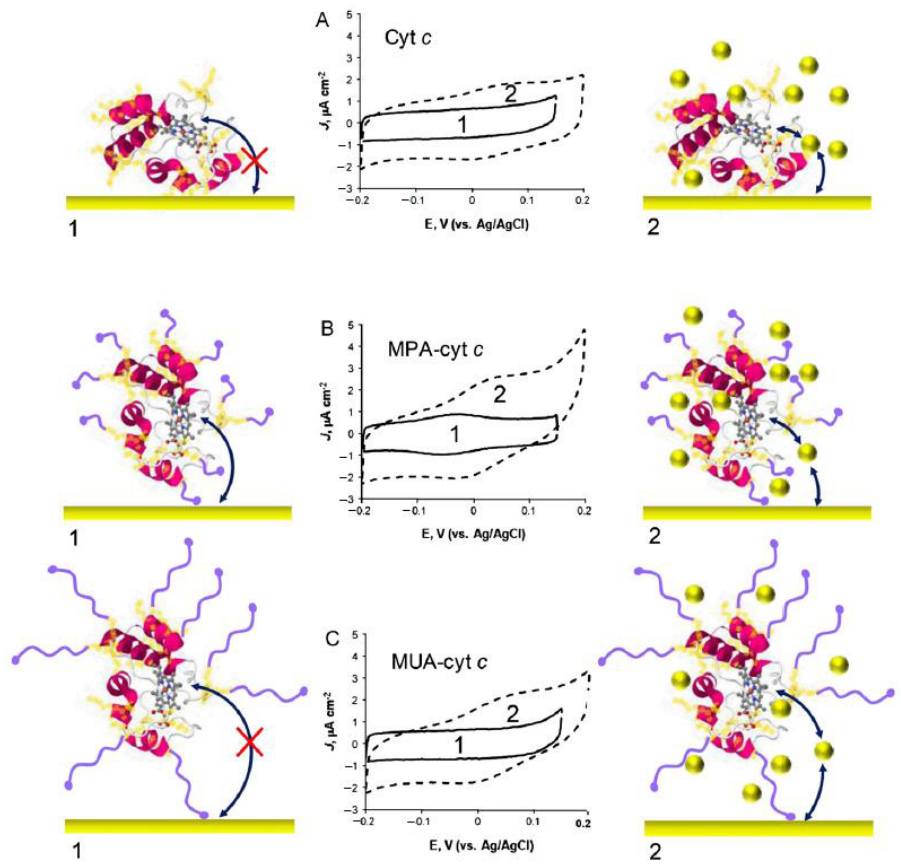
Figure 10. Schematic representation and electrochemical response of native and chemically modified cytochrome c (cyt c ) adsorbed on Au electrodes. Cyclic voltammograms obtained with ( A ) native, ( B ) mercapto-propionic acid (MPA) modified, and ( C ) mercapto-undecanoic acid (MUA) modified cyt c in the (1) absence or (2) presence of AuNPs. MPA and MUA anchors are represented in purple; AuNPs are shown as yellow spheres; black arrows represent the ET between heme group and electrode. Reprinted from Suárez et al. [246], Copyright (2013), with permission from Elsevier.